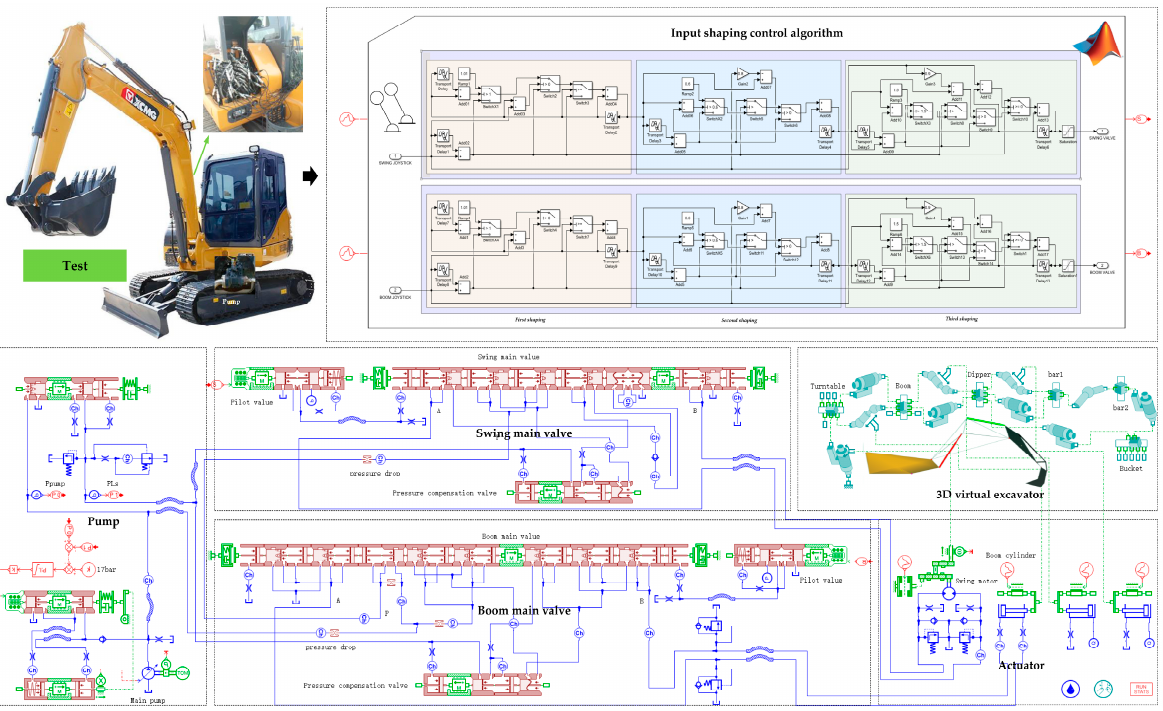
Figure 8. Test and simulation of a 6-ton LUDV excavator.